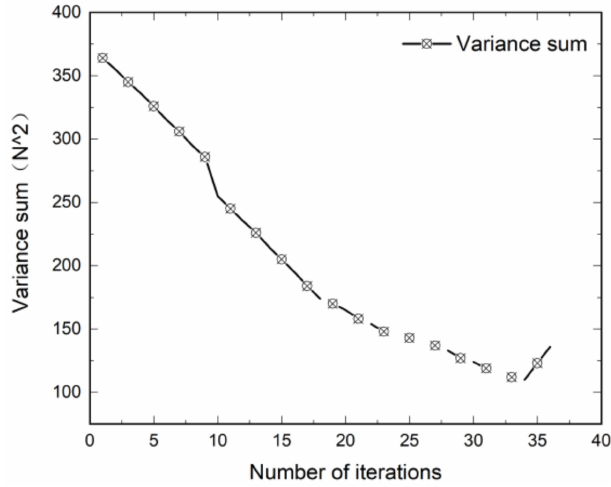
Figure 16. Curve of tracking error in optimized time